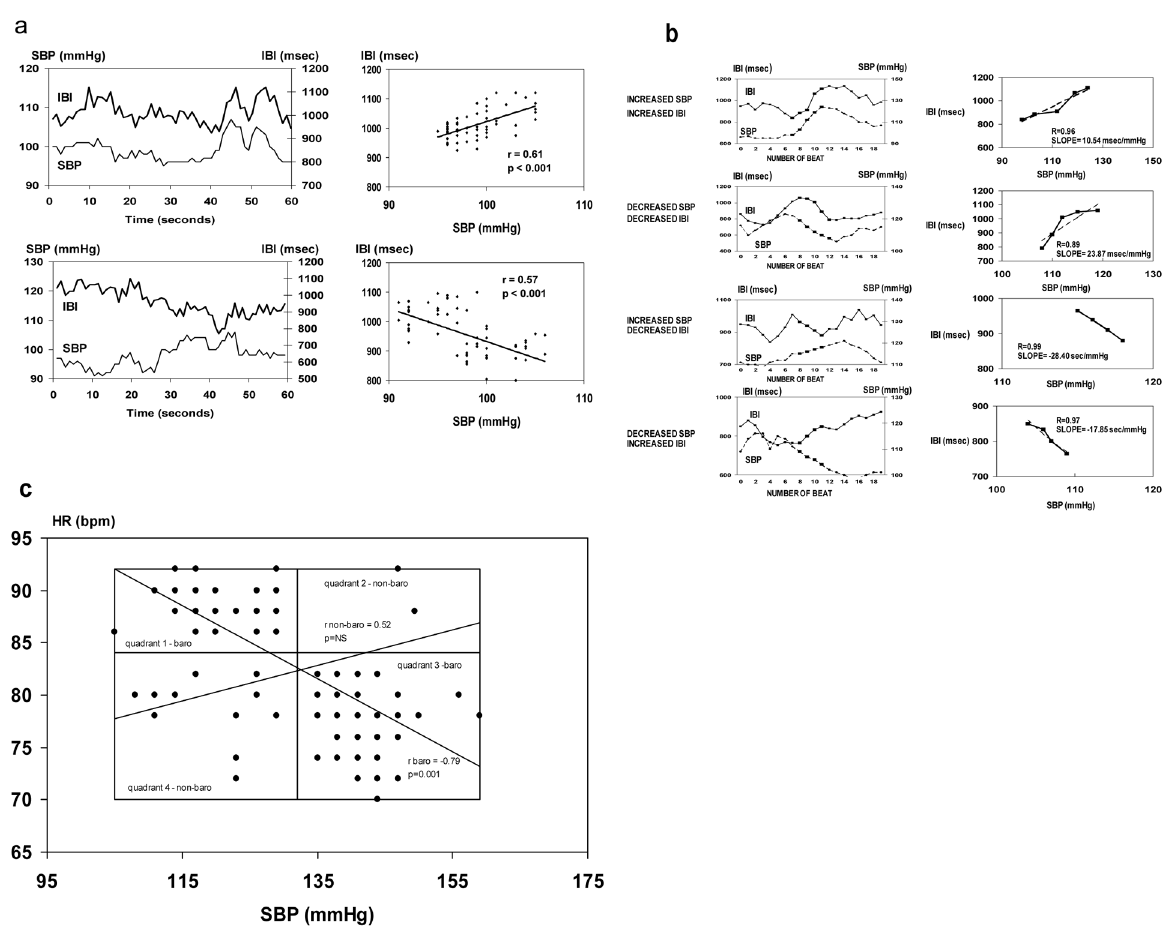
Figure 1. Baroreflex and non-baroreflex function determined by three methods. SBP-systolic blood pressure; IBI-interbeat interval; HR- heart rate. ( a ) The sliding window method: SBP and IBI tracings and their correlations during a baroreflex episode (SBP and IBI change in the same direction, upper panel) and during a non-baroreflex episode (SBP and IBI change in different directions, lower panel). ( b ) The sequence technique: SBP and IBI tracings and their correlations during baroreflex episodes (SBP and IBI change in the same direction, increased or decreased SBP, upper panels) and during nonbaroreflex episodes (SBP and IBI change in opposite directions, increased or decreased SBP, lower panels). ( c ) The "Z" method: Three dimensional histogram for couples of SBP and HR. The modal class (the maximal, most frequent HR-SBP histogram value) was taken as a set point of spontaneous activity. The SBP-HR pair classes in quadrant 1 (low SBP associated with high HR values) and in quadrant 3 (high SBP associated with low HR values) are representative of baroreflex episodes, while quadrants 2 (low SBP with low HR) and 4 (high SBP with high HR) represent non-baroreflex episodes. Regression lines and correlation coefficients are shown for baroreflex episodes (quadrants 1 and 3) and for nonbaroreflex episodes (quadrants 2 and 4). doi: